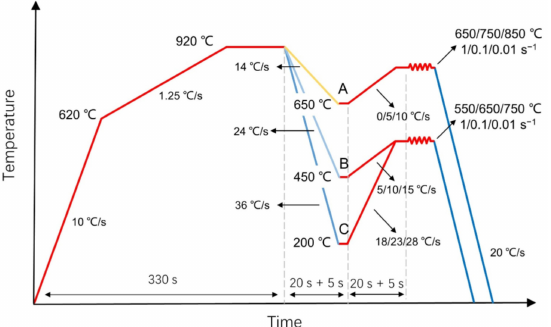
Figure 4. Experiment process of the hot tensile testing (units in mm). Red lines (heating and isothermal), Yellow lines (slow cooling), blue and dark blue lines (fast